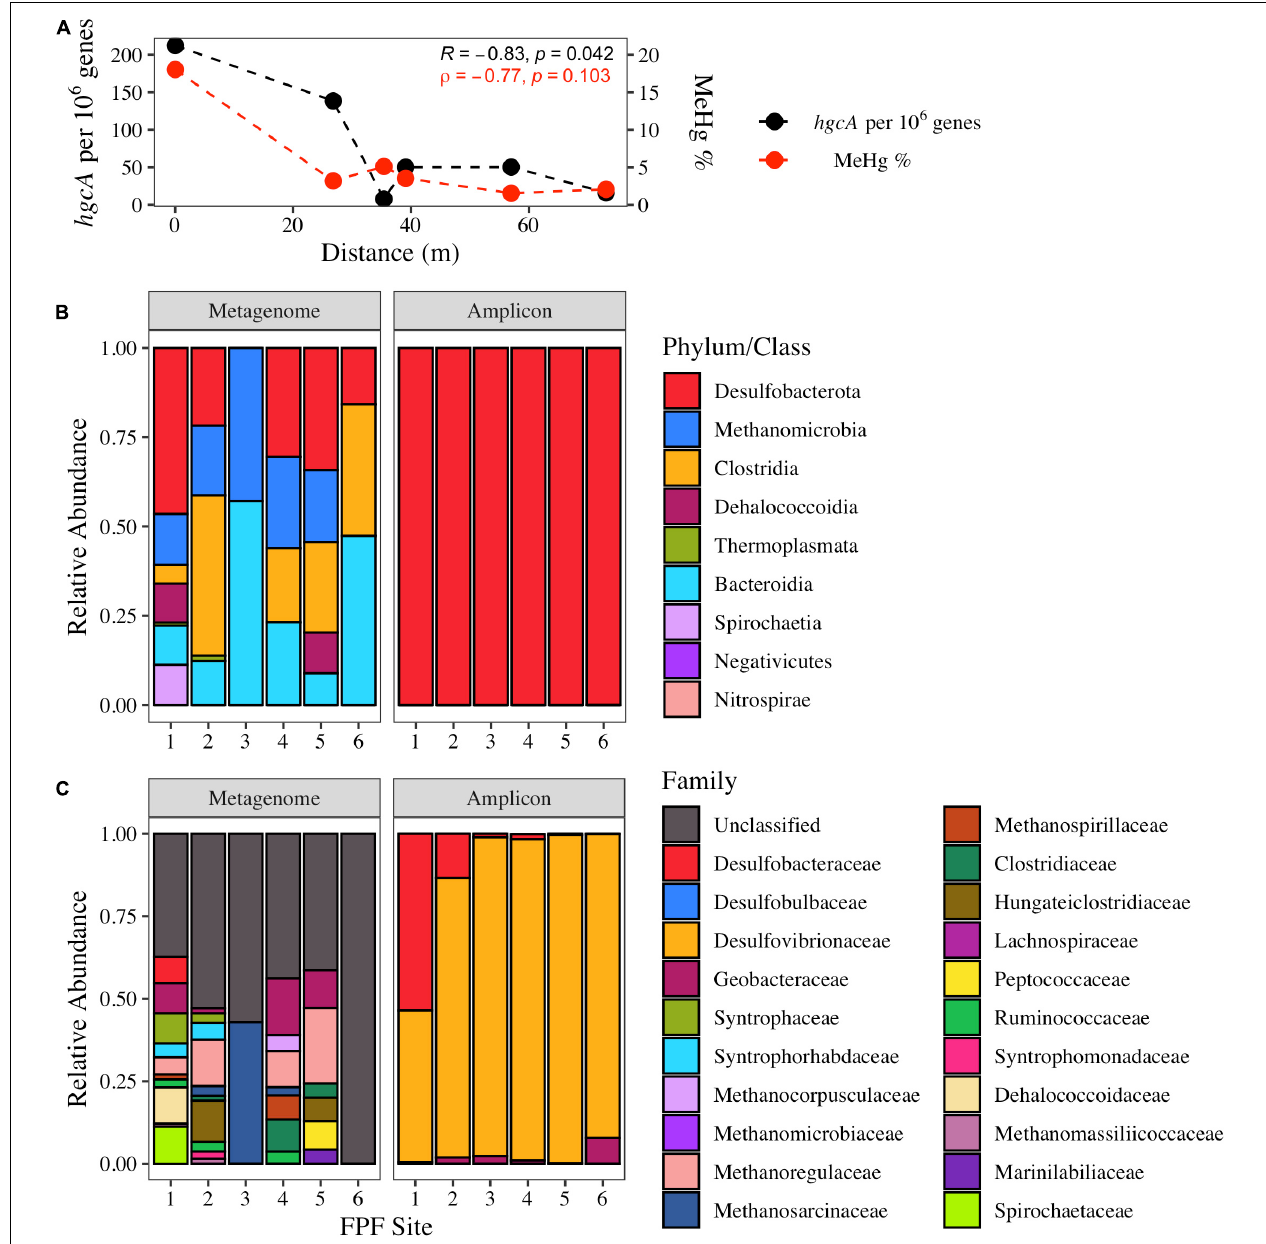
FIGURE 2 | The abundance and taxonomic distribution of hgcA genes in Frozen Pond Fen in 2016 and their relationship with pore water %MeHg. (A) Normalized hgcA gene copies in shotgun metagenomes and the %MeHg decline with increased distance across the fen gradient. Pearson (R) and Spearman ( ρ ) correlation statistics are displayed. (B) Class level distribution of hgcA sequences from the shotgun metagenomes (left) and amplicon sequencing (right). (C) Family level distribution of hgcA reads from shotgun metagenomes and amplicon